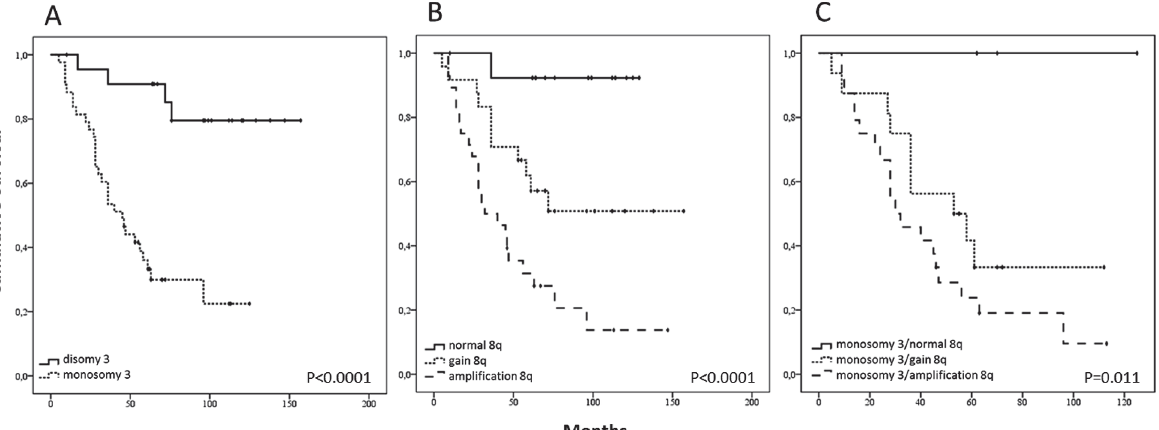
Fig 6. Worst survival for patients with amplification of chromosome 8q. The presence of monosomy 3 (n = 43) in UM is highly prognostic for death due to metastases compared to the presence of disomy 3 (n = 23) (p < 0.0001). (A) Significant differences in survival between classes of tumours with normal (n = 14), gain (n = 24), or amplification (n = 28) of chromosome 8q. A significant difference in survival was observed between the three categories (p < 0.0001), and between the different individual classes: normal vs. amplification (p < 0.0001), and gain vs. amplification (p = 0.00125). Between normal and gain of 8q a trend towards significance was observed (p = 0.07). (B) On the background of monosomy 3, 8q amplification (n = 24) increased the risk significantly (p = 0.011) compared to monosomy 3 with 8q gain (n = 16). Three UM presented monosomy 3 without aberration on 8q: none died due to UM metastasis.